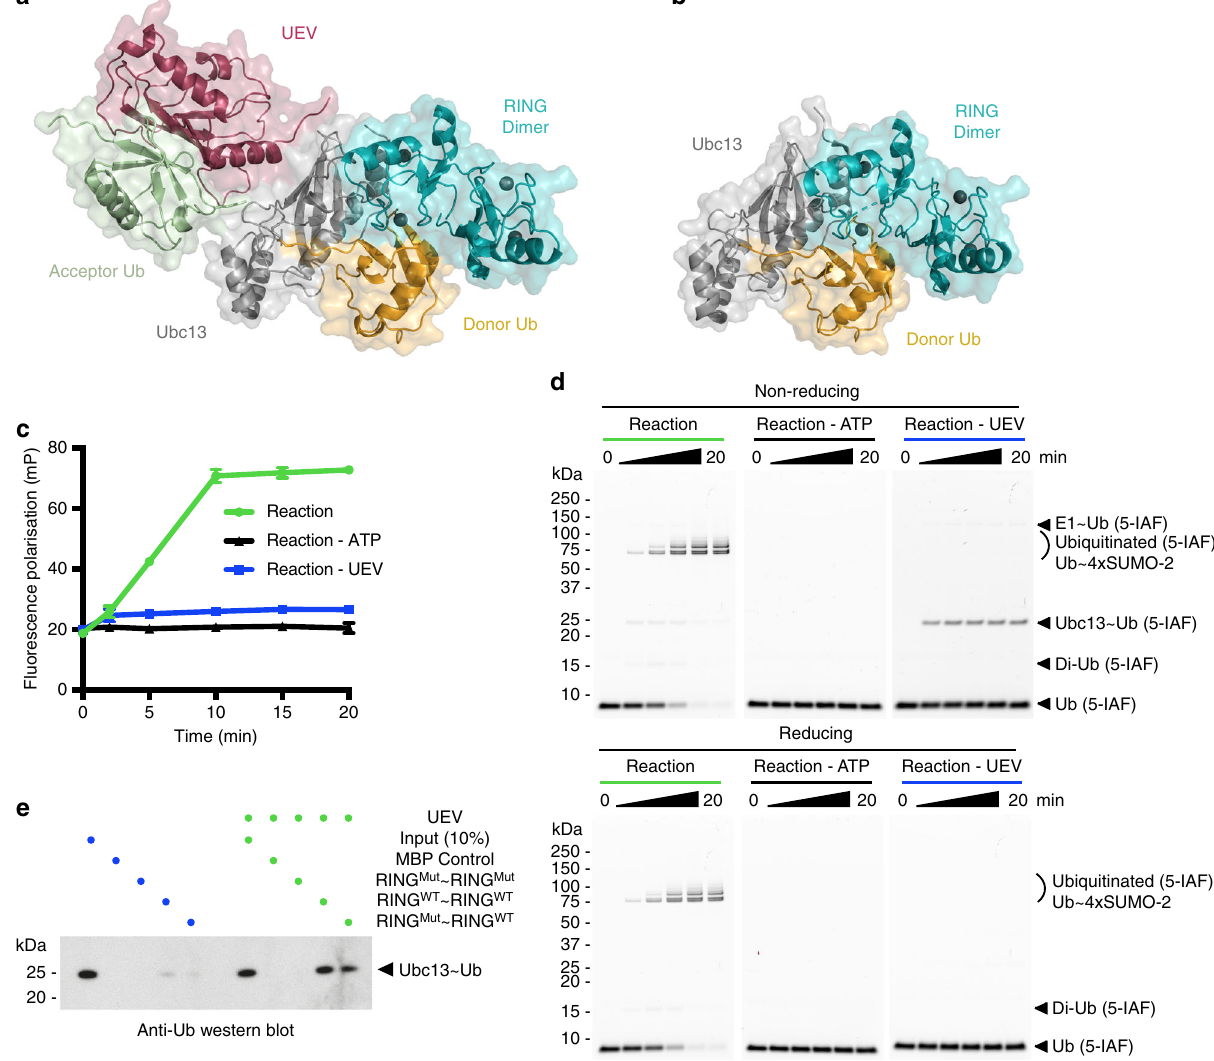
Fig. 1 RNF4/Ubc13~Ub assembly and ubiquitin transfer requires UEV. a Structural model of the RNF4 RING domain dimer (cyan) in complex with the Ubc13~Ub conjugate (Ubc13 in grey, Ub in yellow), UEV (raspberry) and acceptor ubiquitin (green) (PDB 5AIT). b Crystal structure of the RNF4 RING domain dimer in complex with the Ubc13~Ub conjugate alone (PDB 5AIU). For a , b , binding of only one Ubc13~Ub conjugate is displayed for clarity. c Fluorescence polarisation ubiquitination assay showing the effect of UEV on K63-linked polyubiquitin chain formation using fl uorescein labelled version of Ubiquitin, Ub (5-IAF). Data points represent the mean of n = 3 independent experiments and error bars represent ±s.d. Data points are represented for the Reaction by green circles, for the Reaction - ATP by black triangles and for the Reaction - UEV by blue squares, with a line drawn in the same colour through each data point in a reaction. Error bars are omitted when the error is smaller than the data point. d SDS-PAGE analysis of fl uorescence polarisation ubiquitination assays shown in c , under non-reducing (above) and reducing (below) conditions imaged using fl uorescein fi lter. e RNF4 RING domain dimer pull-down experiment showing the effect of UEV on Ubc13~Ub conjugate binding, analysed by western blot. WT denotes a wild-type RING domain, while Mut denotes a RING domain containing E2~Ub binding site mutations (M140A and R181A). Linearly fused RING domain dimers are used to ensure the RING domain dimers of RNF4 are constitutively dimeric. For d , e , the same colour scheme is used as in c . Source data are provided as a Source Data fi